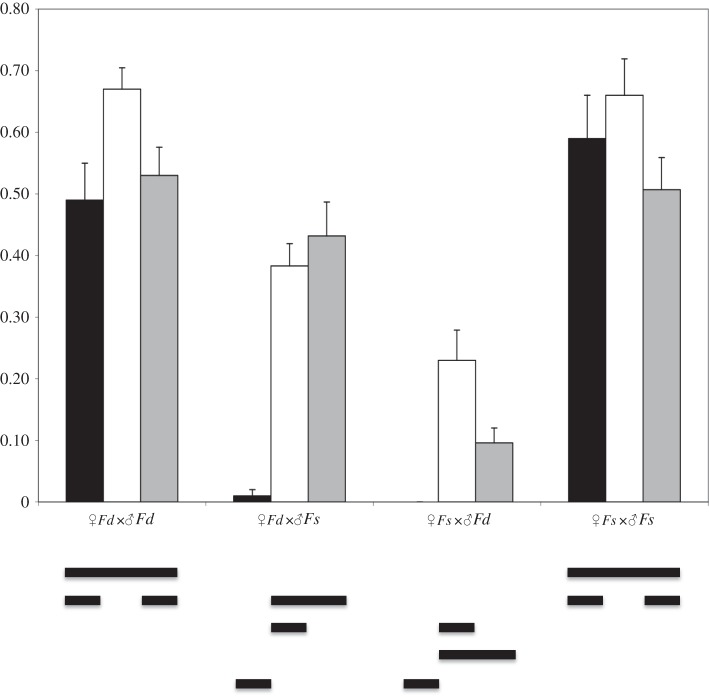
Fertilization success (the presence of one-week-old embryos) for all combinations of laboratory crosses (sample size=100). Black=Tromsø, white= Heimaey, grey=Blushøj, Kirkenes not tested. Means grouped by a horizontal line are not significantly different from each other (Tukey post hoc, p>0.05).